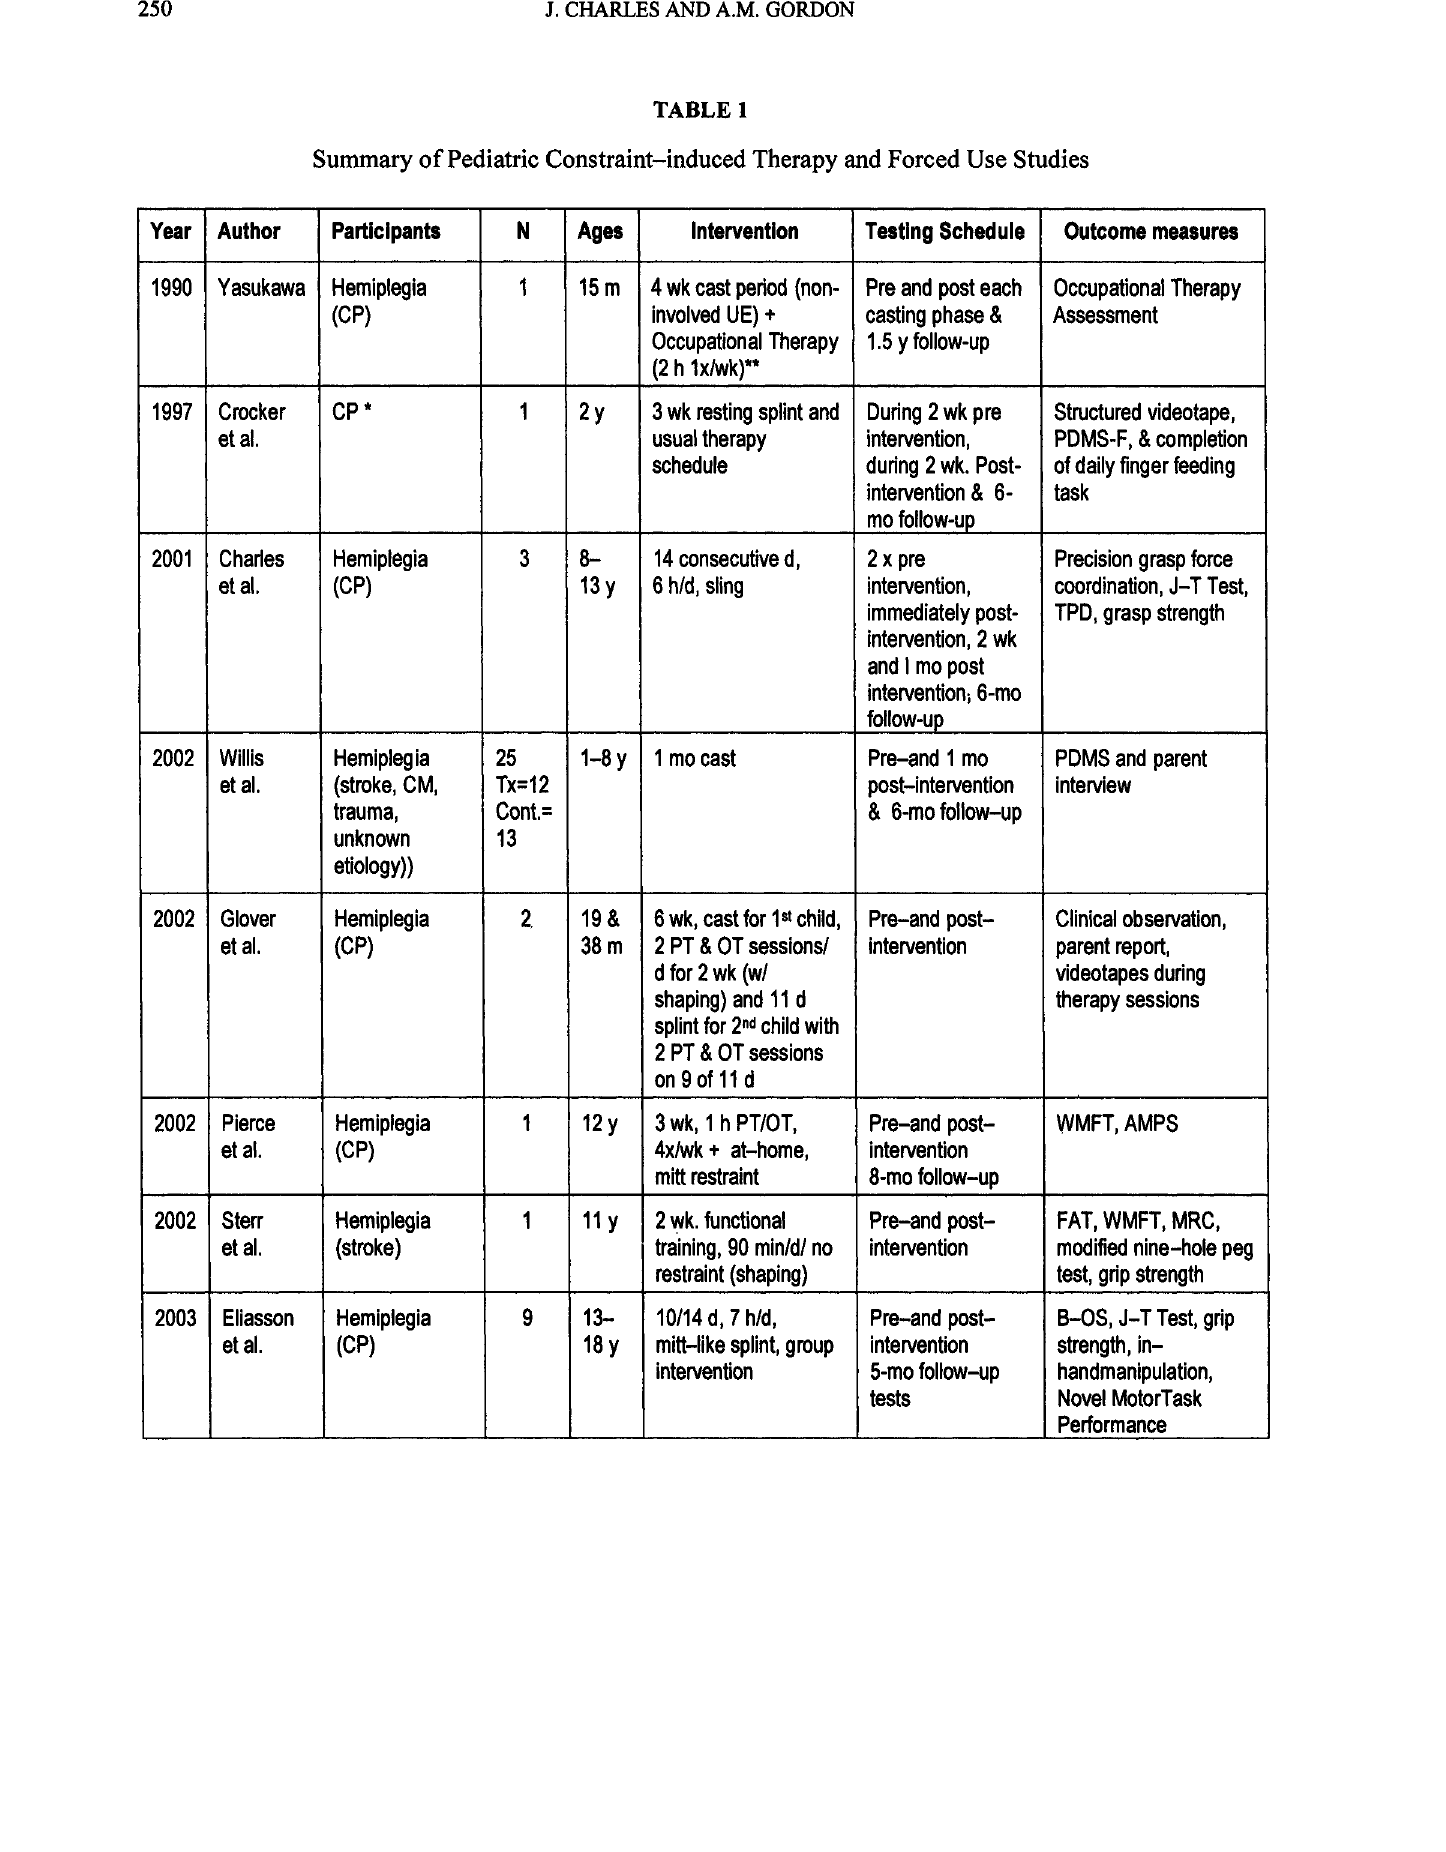
Summary of Pediatric Constraint-induced Therapy and Forced Use